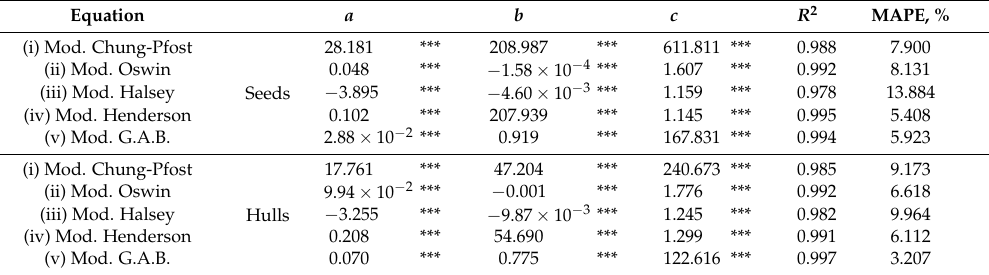
Table 2. Coefficients a , b , and c , coefficient of determination R 2 and MAPE for the (i) Mod. Chung-Pfost, (ii) Mod. Oswin, (iii) Mod. Halsey, (iv) Mod. Henderson, and (v) Mod. G.A.B. equation fitted for high oleic sunflower seeds in the range of 10–70% equilibrium relative humidity at 31 degrees of freedom and hulls in the range of 10–80% equilibrium relative humidity and 34 degrees of freedom. Equation a b c R 2 MAPE,